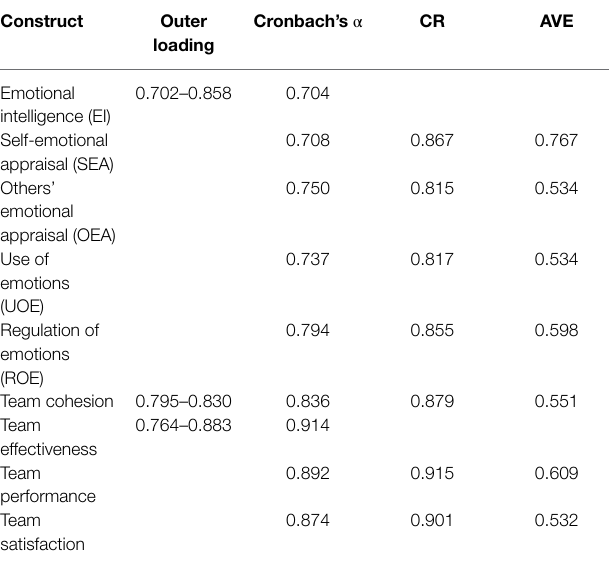
TABLE 2 | Summary of reliability and validity analysis results.